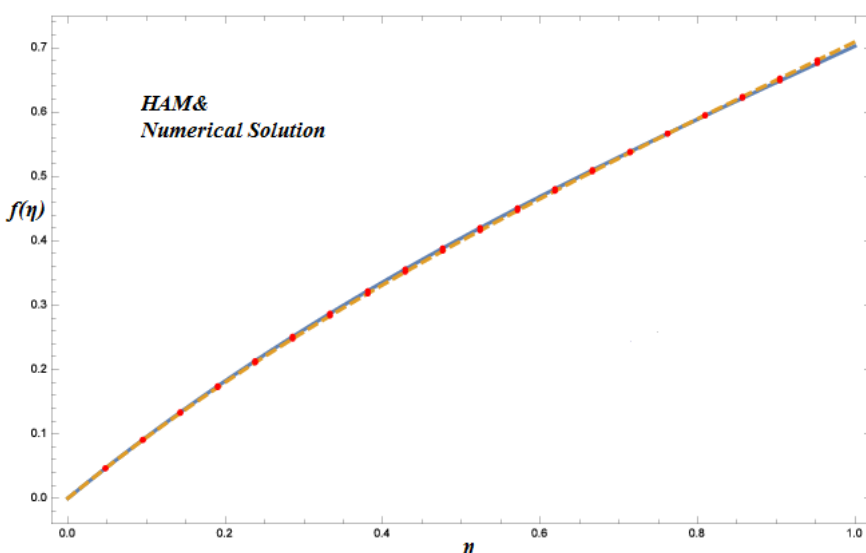
Figure 4. The comparison between HAM and numerical solutions for velocity profile f ( η ) , when (cid:125) = − 0.28, P r = 10, B r = 0.1, N r = 0.1, D u = 0.1, S c = 0.1, ε = 0.1, S r = 0.1, λ = 0.1, Λ = 0.1, β = 1, S = 0.1.